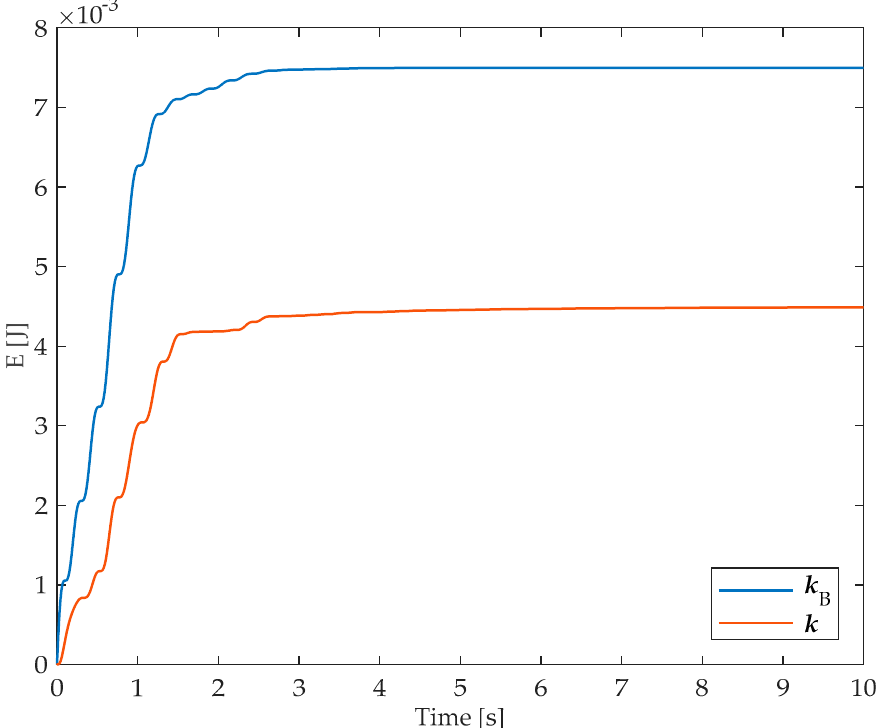
Figure 7. Control energy for the controlled systems: traditional PPP and the proposed method (test-case 2).